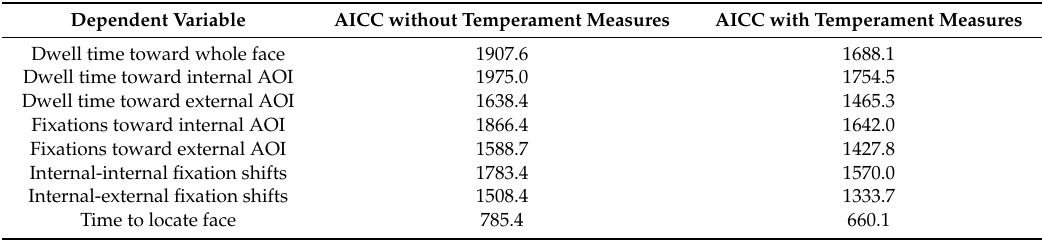
Table 4. Comparison of the linear models excluding and including infant temperament measures using Akaike’s information criterion corrected